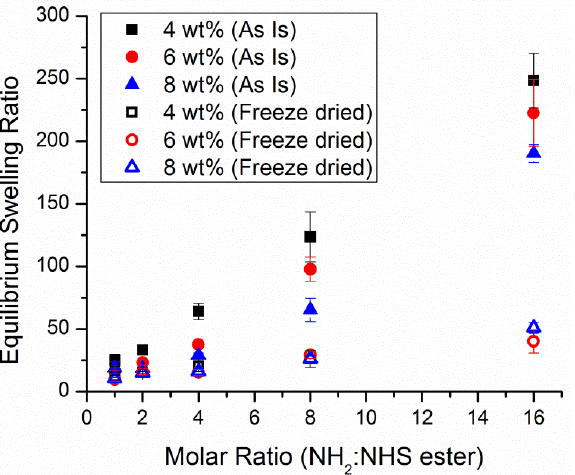
Figure 6. Equilibrium swelling of “as-prepared” and freeze-dried hydrogels as a function of NH 2 /NHS ester molar ratio is shown for 4 wt%, 6 wt% and 8 wt% hydrogels. The effect of molar ratio on the ESR was statistically significant for both “as-prepared” and freeze-dried hydrogels, as determined from Student’s t -tests ( p < 0.05). The effect of hydrogel concentration was only statistically significant fo r the “as -prepared ” hydrogels ( p < 0.05).